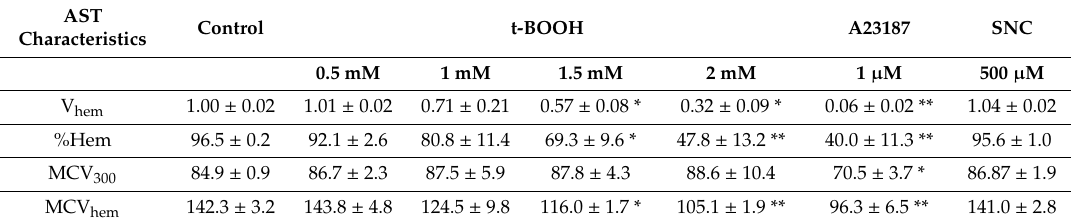
Table 3. Quantification of ammonium stress-test data of five independent experiments (donors). AST